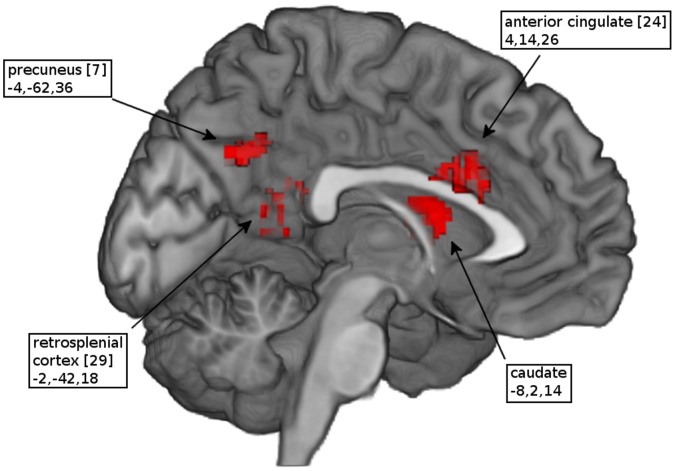
Activation map of patients contrasted with controls.Significant activations of PTSD patients compared to trauma-exposed controls in response to trauma-related stimuli. (Numbers in brackets indicate Brodmann areas and coordinates of the peak voxel are in Talairach space).